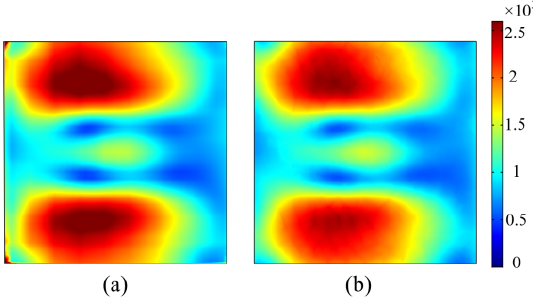
Figure 7. The comparison of electric field distribution at the center section of the potato ( t = 10 s): ( a ) proposed method; ( b ) conventional method.